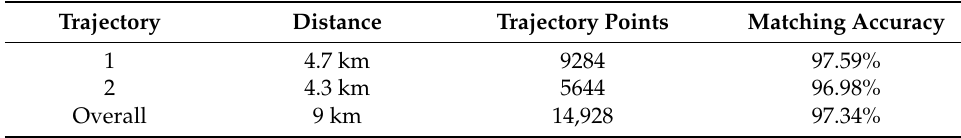
Table 1. Trajectory matching